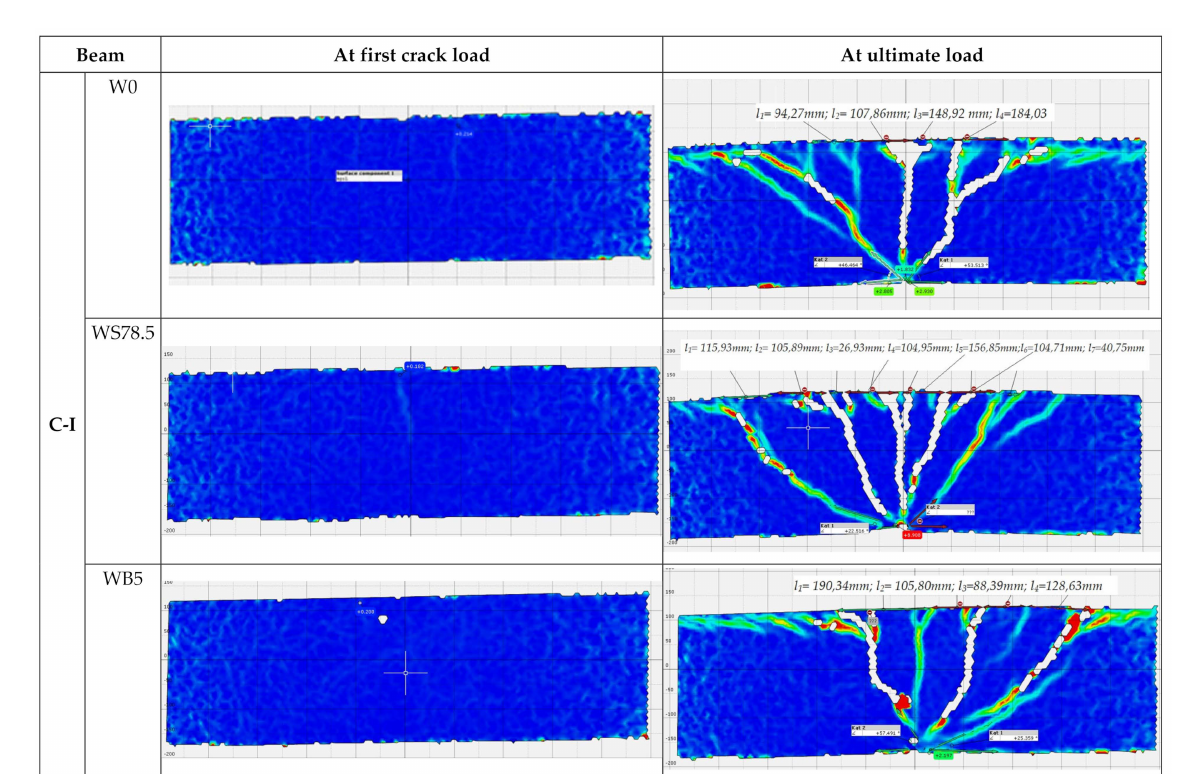
Figure 8. Principal strain contours in the center support in series C-I ( l is spacing between cracks in mm).